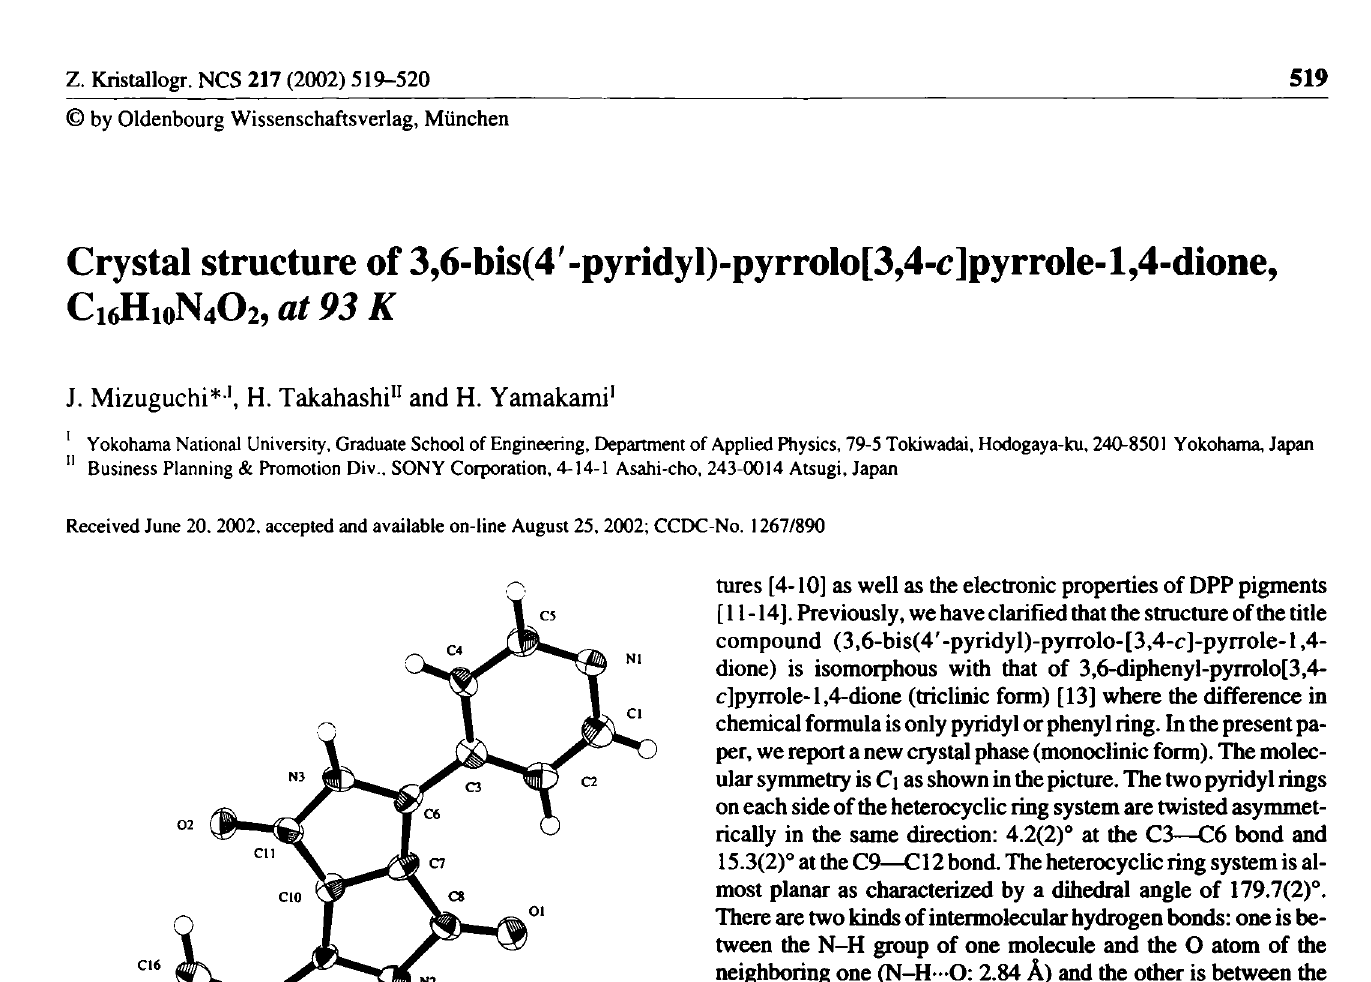
Table 1. Data collection and